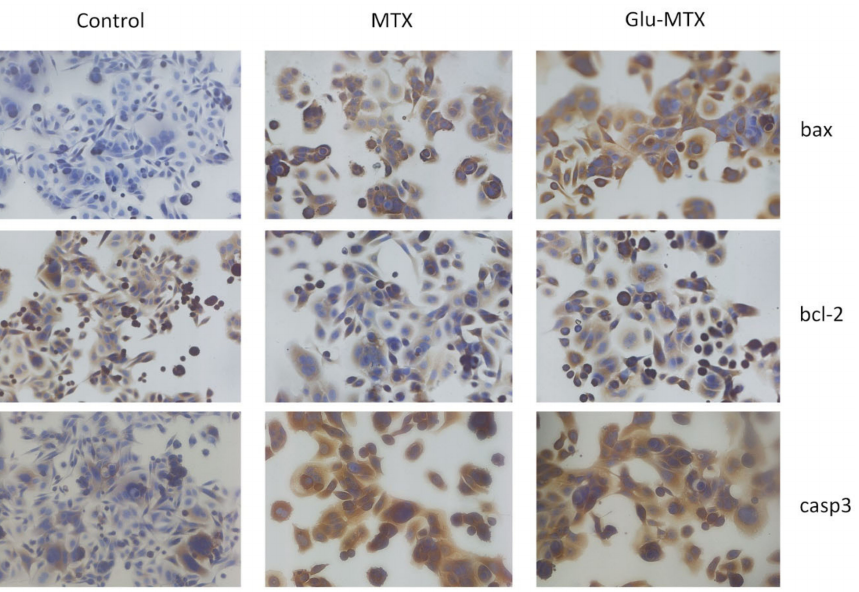
Figure 4. Representative images of the immunocytochemical analysis of bax, bcl-2, and caspase 3 apoptosis-related proteins in the SW480 cell line in control, treated with 10 µ M of MTX and Glu-MTX samples after 48 h. 20 × and 40 × objectives were used to capture the